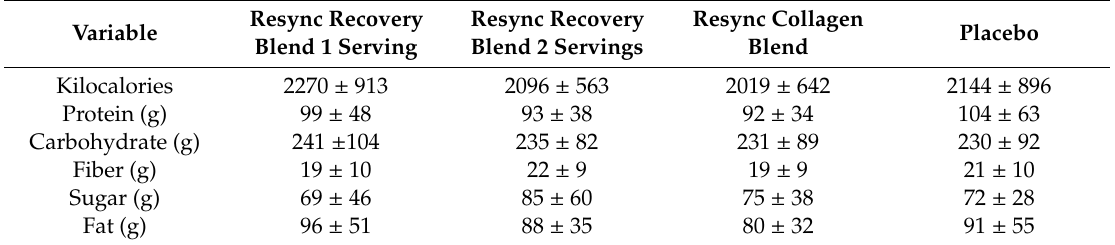
Table 2. Dietary data of men and women during the two days prior to each test